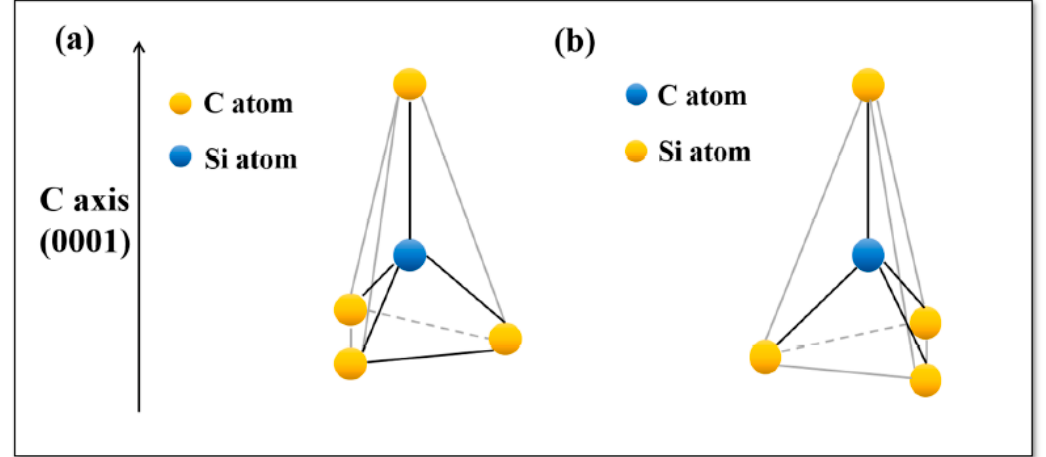
Figure 1. Elongated tetrahedron with C 3v symmetry of the hexagonal polytype: ( a )—SiC 4 each silicon atom is bonded to 4 carbon atoms and ( b )—CSi 4 each carbon atom is bonded to 4 silicon atoms.